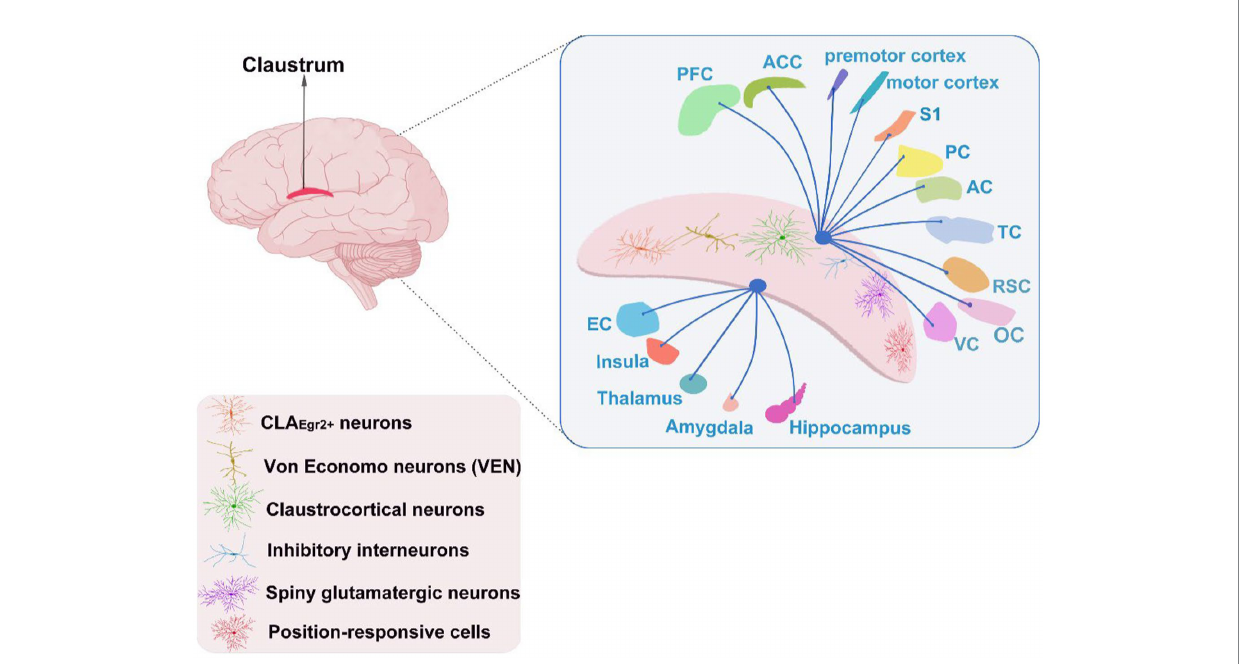
FIGURE 1 The cognitive neuronal types of the CLA and its interconnection with other brain areas. PFC, prefrontal cortex; ACC, anterior cingulate cortex; S1, primary somatosensory cortex; PC, parietal cortex; AC, auditory cortex; TC, temporal cortex; RSC, retrosplenial cortex; VC, visual cortex; EC, entorhinal cortex; OC, occipital